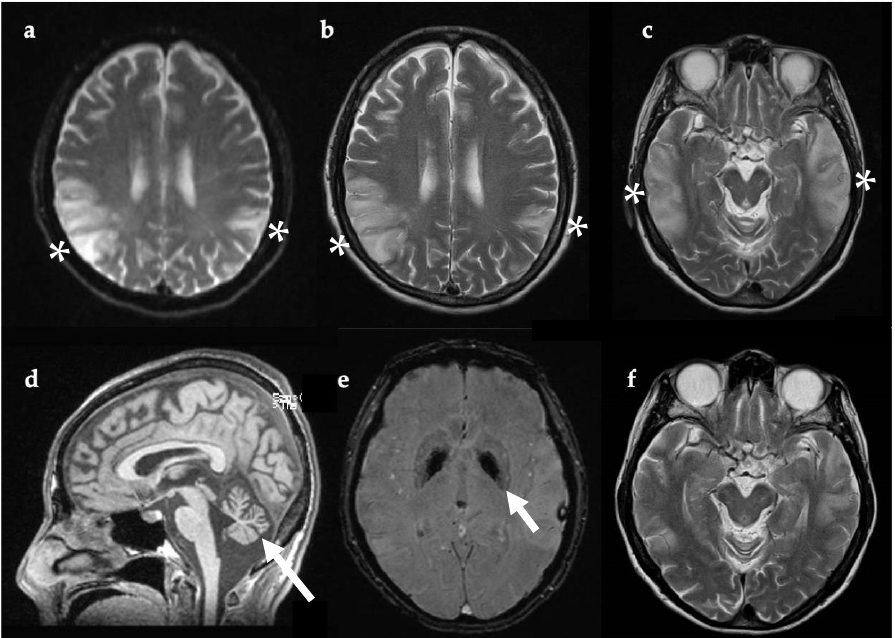
Figure 2. Axial ( a – c , e , f ) and sagittal ( d ) brain MRI, 11 days after symptom onset ( a – e ) and one year later ( f ). Bilateral temporoparietal cortical and gyral swelling shown with white asterix in ( a ), DWI ( b ), and ( c ) T2w. Evidence of cerebellar atrophy ( d , white arrow). SWI sequence showing pallidal mineralization ( e , white arrow). MRI one year later ( f ) showed regression of lesions previously evident ( c ). Abbreviations: DWI, diffusion-weighted imaging; SWI, susceptibility-weighted imaging; T2w, T2-weighted imaging.